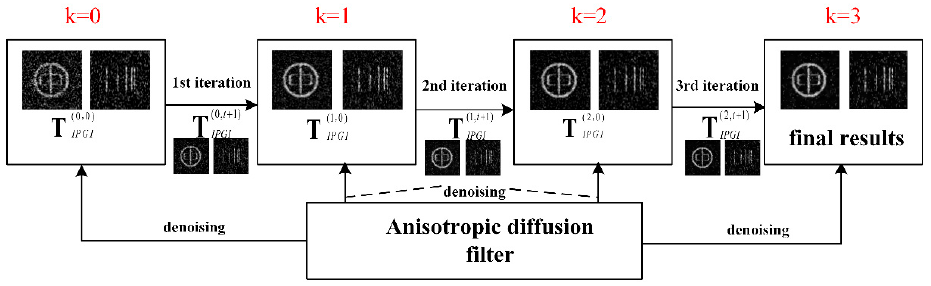
Figure 2. The imaging process of our method.